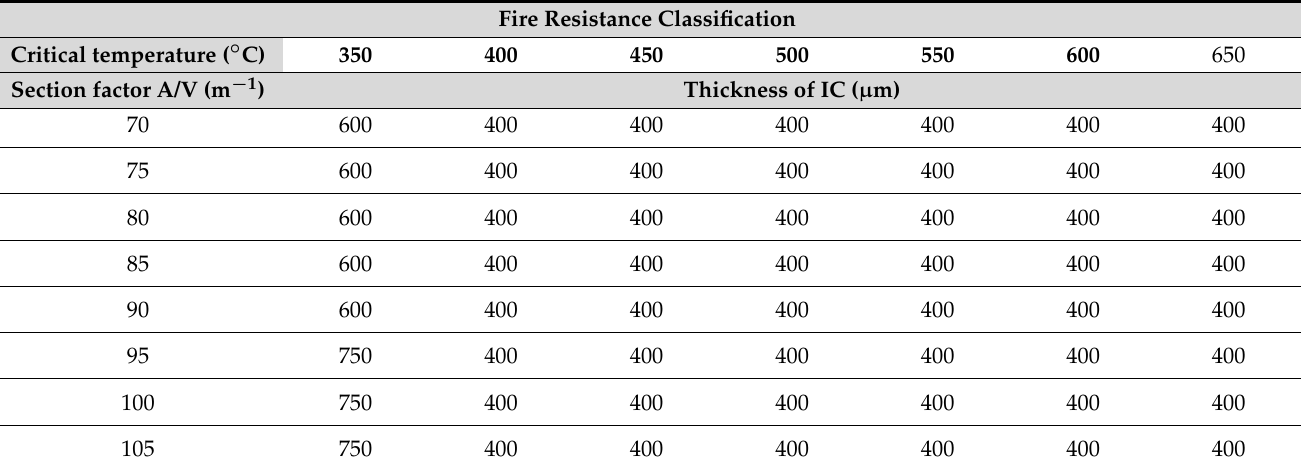
Table 1. Typical table for the prescriptive design of IC